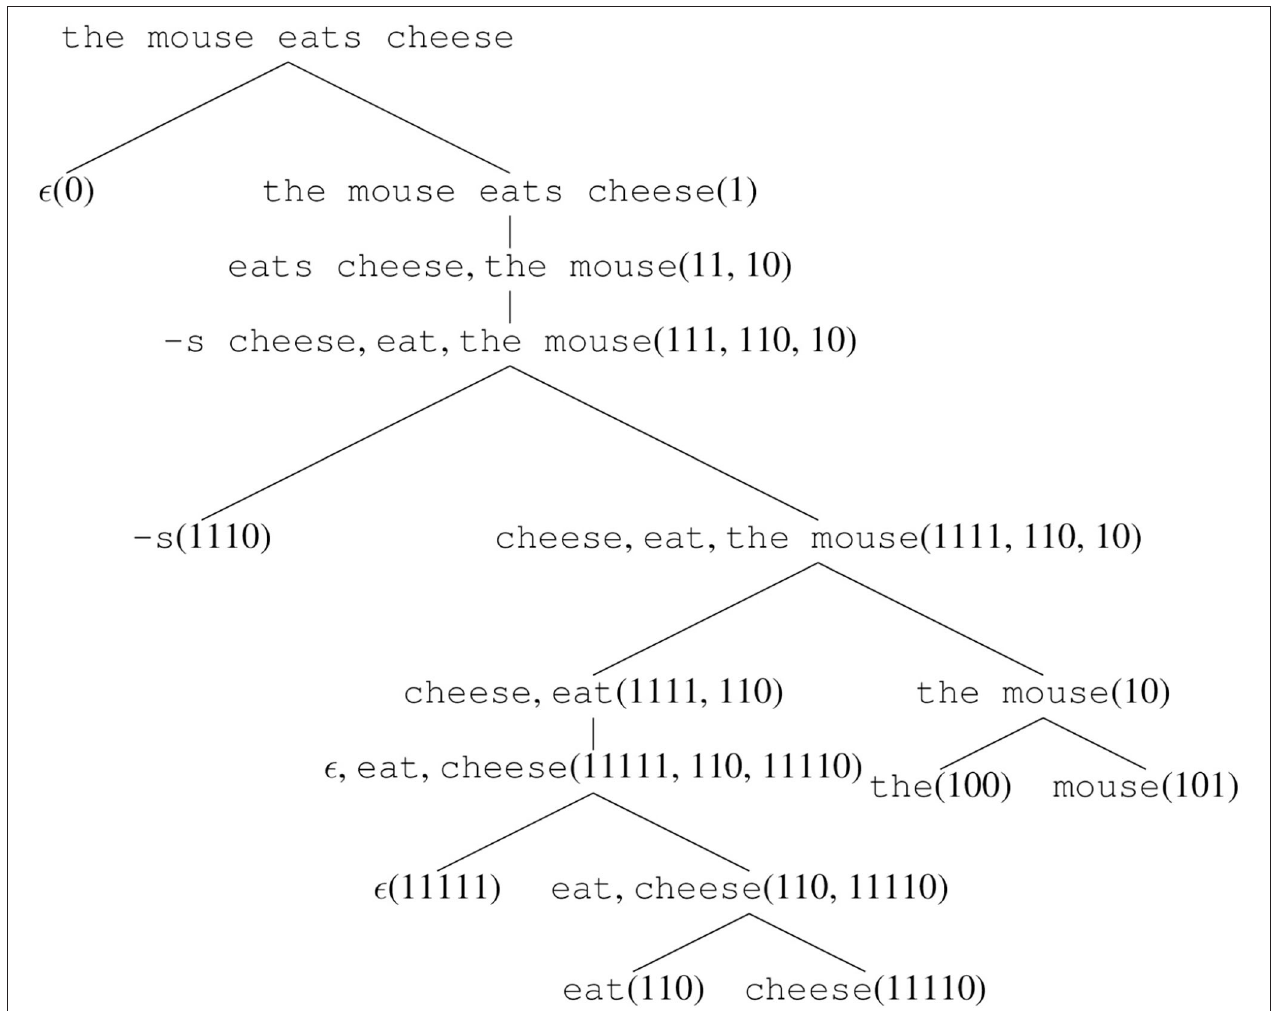
FIGURE 3 | Simplified derivation tree of Equation (19). Exponents of different signs are separated by commas. Nodes are also addressed by index tuples.